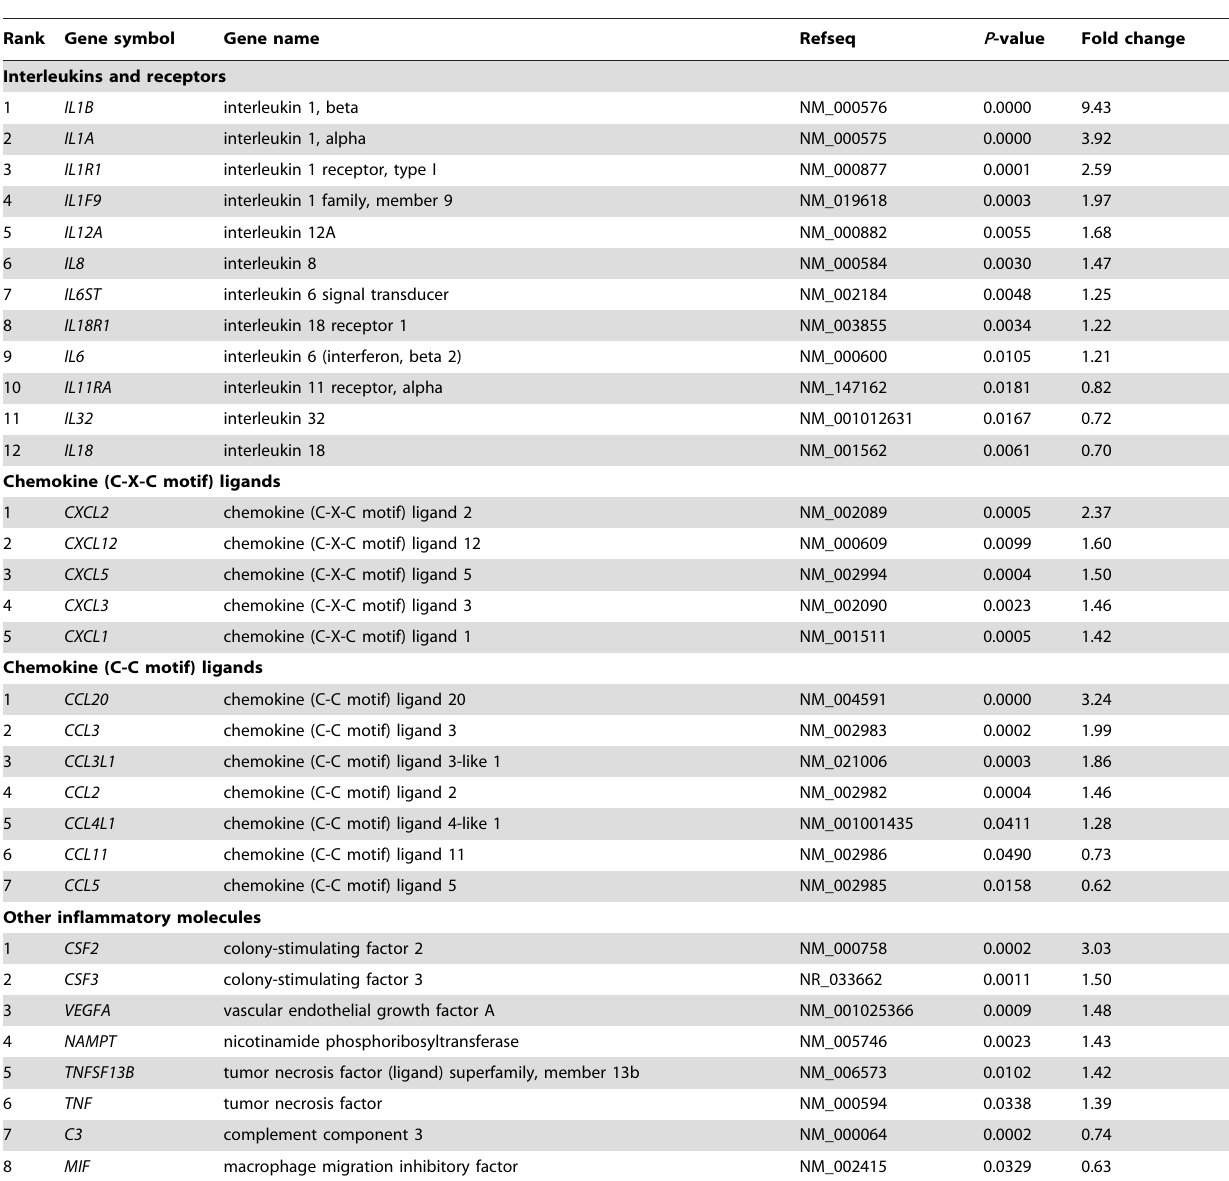
Table 2. Altered expression of inflammation-associated genes in indoxyl sulfate-exposed human podocytes.